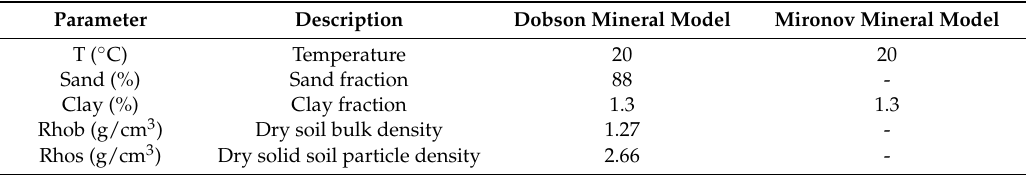
Table 2. Parameters chosen for dielectric modeling using the Dobson and Mironov mineral models, respectively, together with average soil properties as encountered in the mineral soil samples used for the resonant cavity